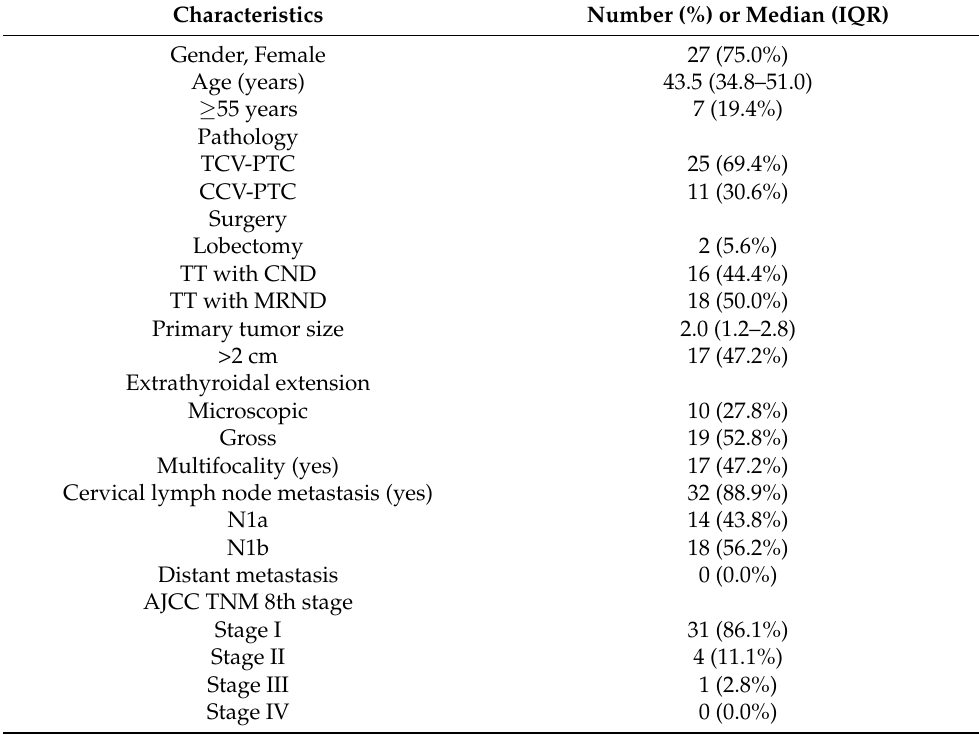
Table 1. Baseline clinical and pathological characteristics of patients with aggressive variants of papillary thyroid carcinoma (PTC).